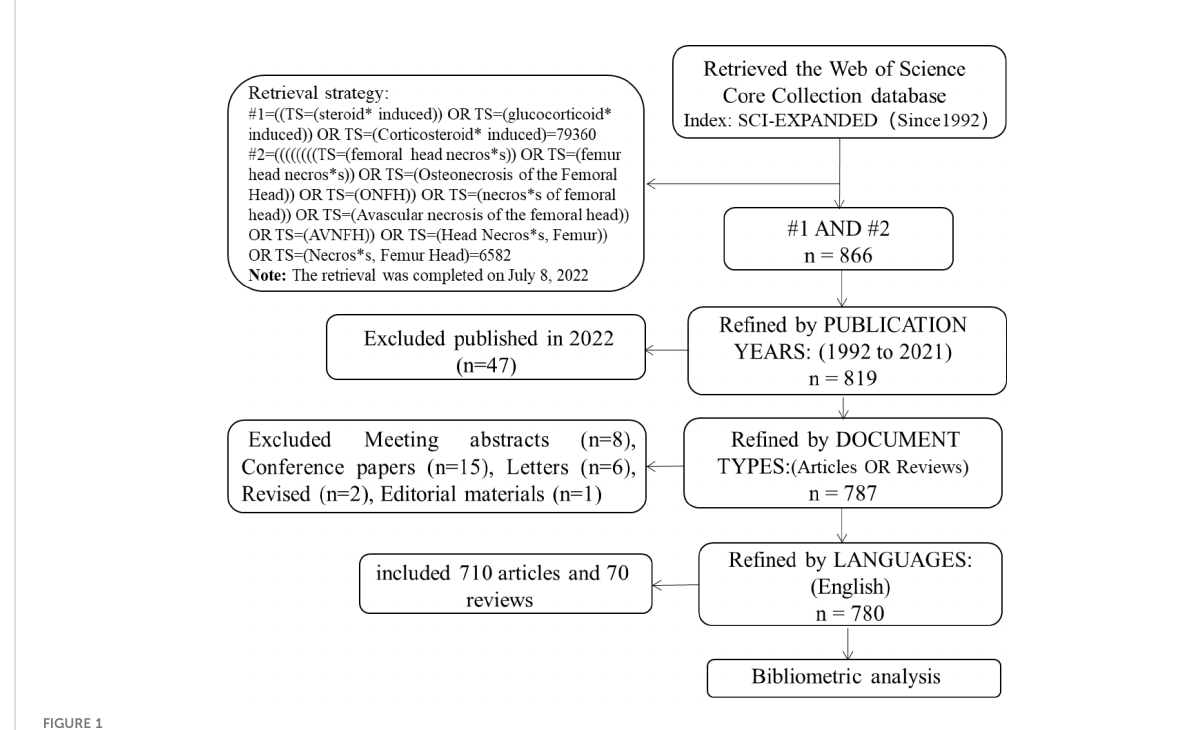
FIGURE 1 Flow chart of SONFH-related literature